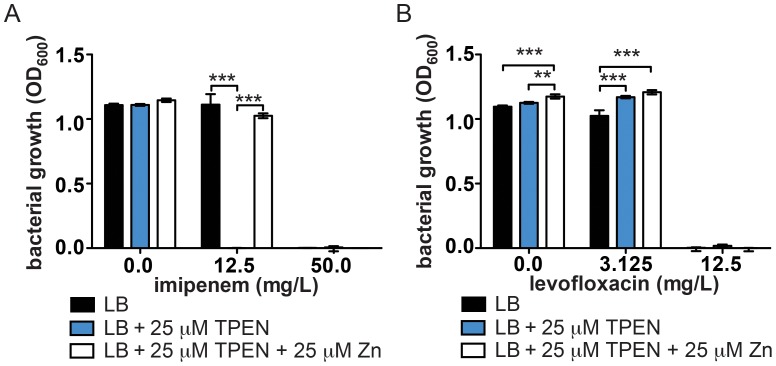
Effect of Zn chelation on resistance to imipenem and levofloxacin in an MDR isolate of A. baumannii.
Bacterial growth measured at 24 hours in LB medium in the presence of increasing concentrations of imipenem (A) or levofloxacin (B) and 25 µM TPEN, with or without addition of excess Zn. Data for concentrations near and above the clinical breakpoints for resistance are shown.